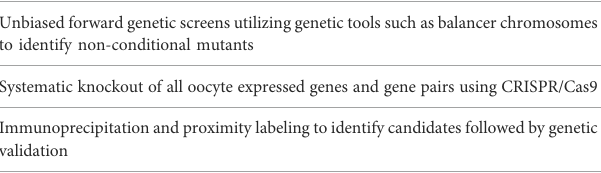
TABLE 2 Solutions to identifying egg